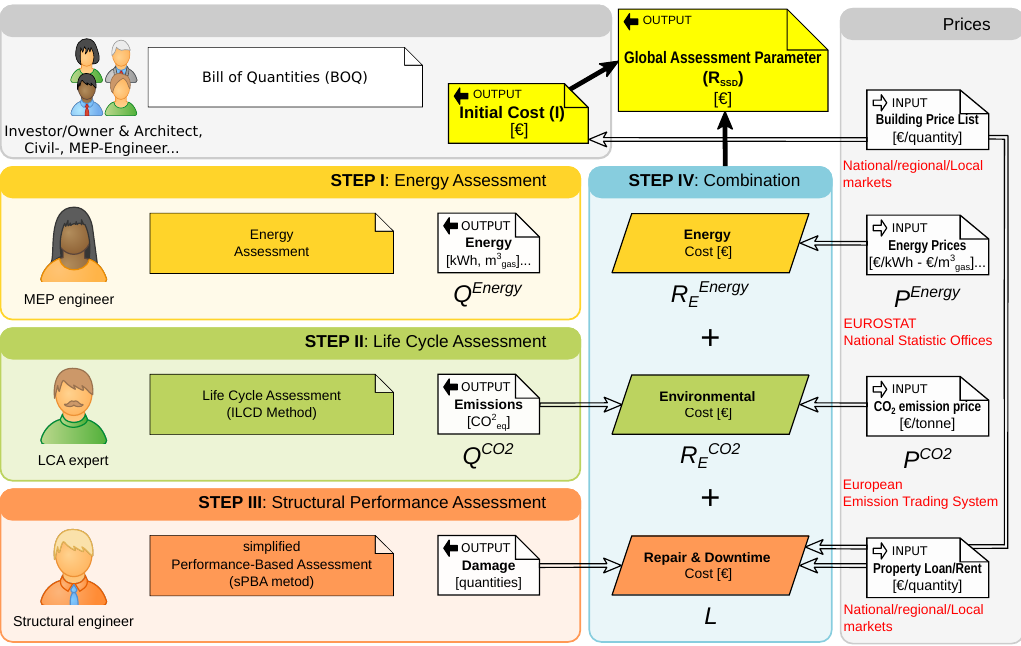
Figure 4. Breakdown of the SSD